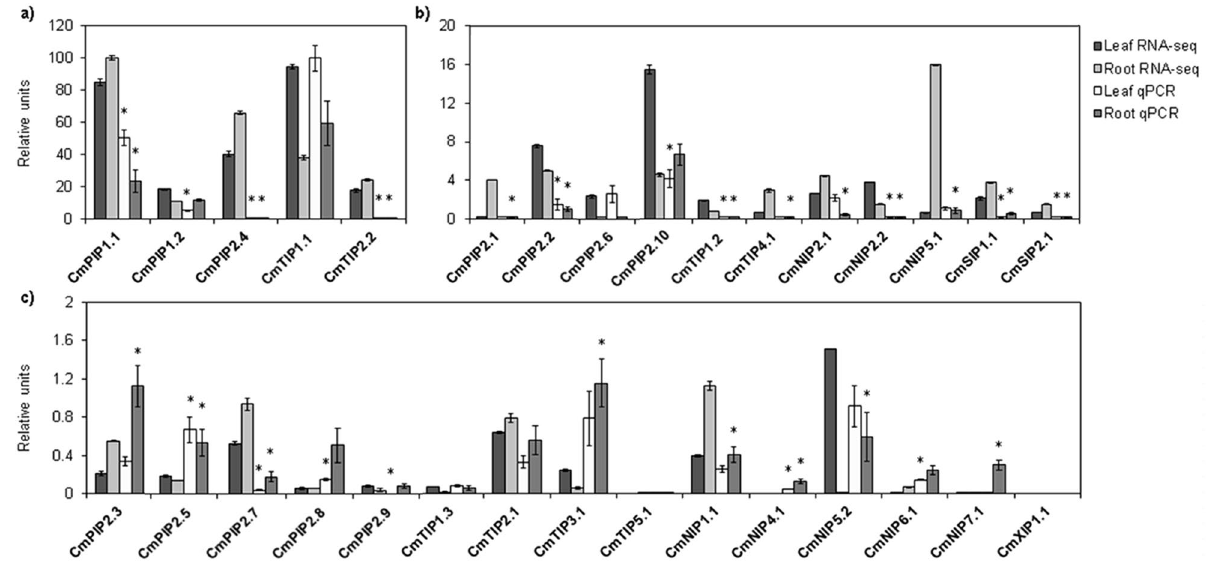
Figure 5. Comparison of the expression levels of aquaporins genes determined by qPCR with RNA-seq analysis in leaves and roots. Statistical analysis was performed using SPSS 25.0.0.1. Each bar represents the mean of 2 biological replicates for the RNA-seq data, and of 3 to 6 biological replicates for RT-qPCR. Columns with * differ significantly according to Tukey’s test ( p = 0.05). Each group is formed by aquaporins genes with similar expression levels represented as relative units (ru). ( a ) Group 1 (20–120 ru): PIP1;1, PIP1;2 PIP2;4, TIP1;1 and TIP2;2. ( b ) Group 2 (2–20 ru): PIP2;1, PIP2;2, PIP2;6, PIP2;10, TIP1;2, TIP4;1, NIP2;1, NIP2;2, NIP5;1, SIP1;1 and SIP1;2 . ( c ) Group 3 (0–2 ru): PIP2;3, PIP2;5, PIP2;7, PIP2;8, PIP2;9, TIP1;3, TIP2;1, TIP3;1, TIP5;1 , NIP1;1, NIP4;1, NIP5;2, NIP6;1, NIP7;1 and XIP1;1. This figure was made using Microsoft Office 2016